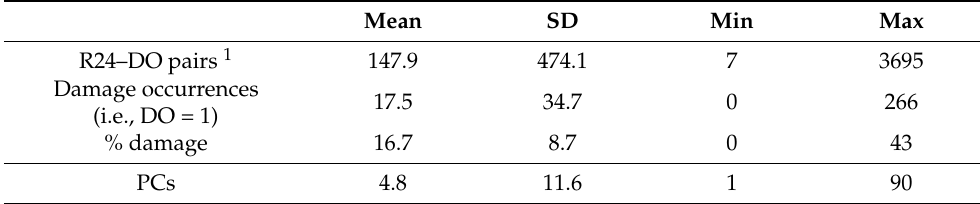
Table 3. Descriptive statistics (mean, standard deviation (SD), min, max) for PCs, R24–DO pairs, and damage occurrences at the municipality level (N =